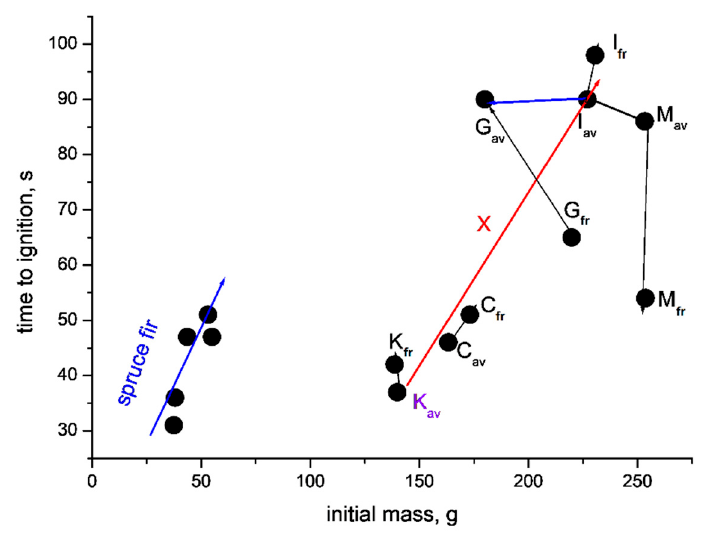
Figure 7. Time to ignition in dependence on the initial mass of the untreated and samples treated with FR.